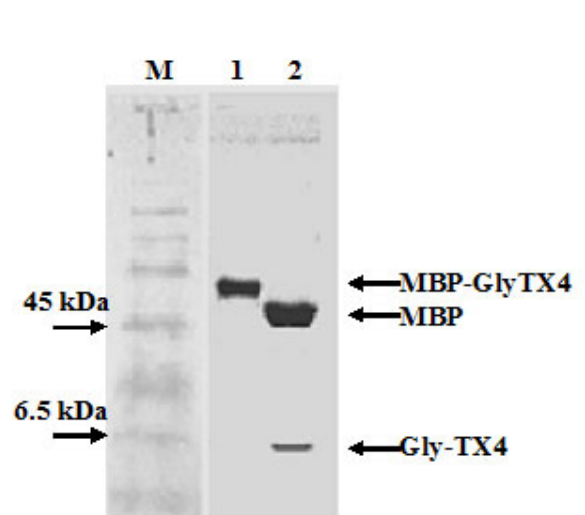
Figure 4. Western blot of the purified MBP-GlyTx4 recombinant protein assayed with rabbit polyclonal anti-MBP-GlyTX4 antibody. Line M: Ponceau-stained molecular weight marker (New England Biolabs, Ipswich, MA, USA); Line 1: Affinity purified recombinant MBP-GlyTX4 protein; Line 2: Affinity purified recombinant MBP-GlyTX4 protein cleaved with the Xa factor. The antibody was diluted